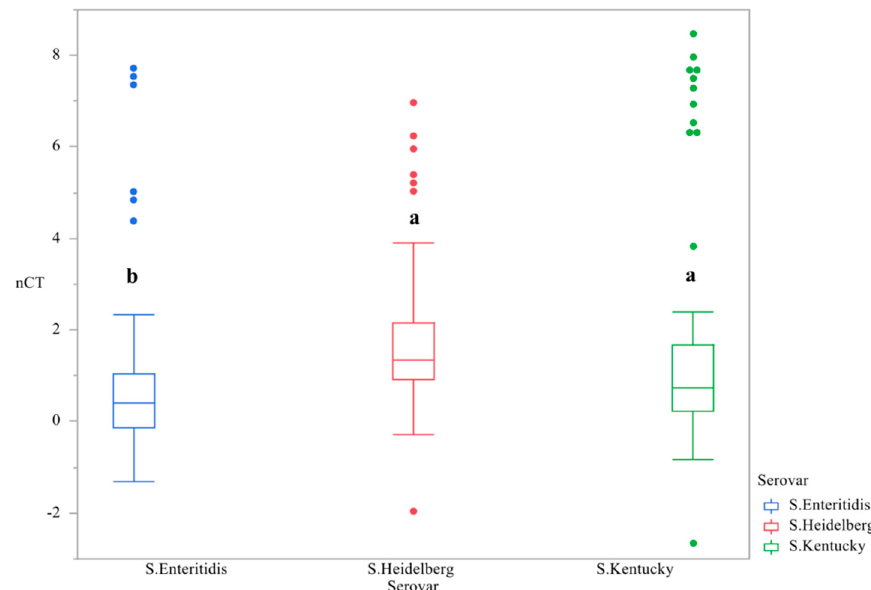
Figure 5. Di ff erences in expression of the gene bcsA between serovars 1,2 . qRT-PCR was performed on total RNA isolated from bacterial cultures of Salmonella as pellicles were being formed over a 4-day time period. 1 N = 270, n = 90, p < 0.0019, Individual SEM was 0.175, 0.152, 0.242 for S. Enteritidis, Heidelberg, and Kentucky. 2 Means with di ff erent superscripts are considered significantly di ff erent (a–b).